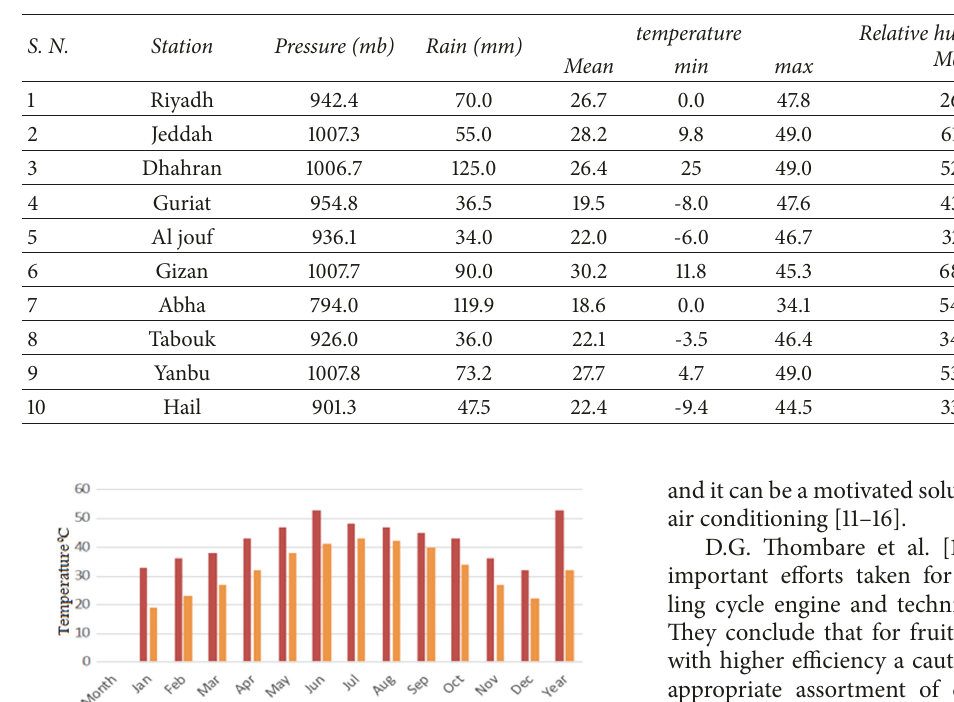
Table 1: Weather data from meteorological station in KSA.